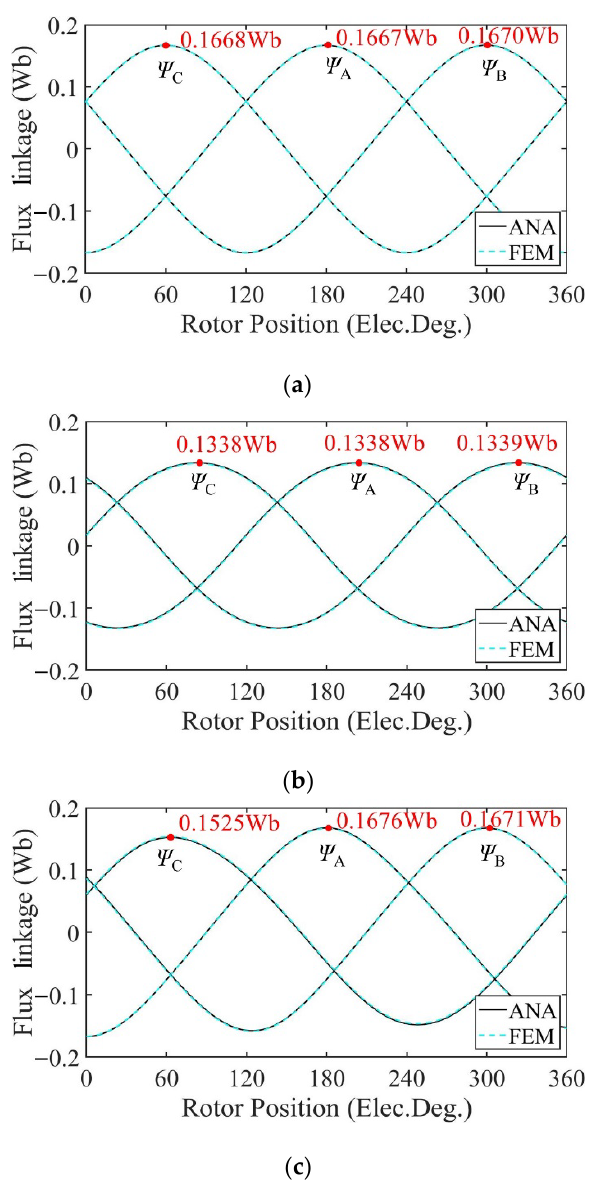
Figure 18. Flux linkage comparison. ( a ) Healthy; ( b ) uniform demagnetization; ( c ) partial demagnetization.